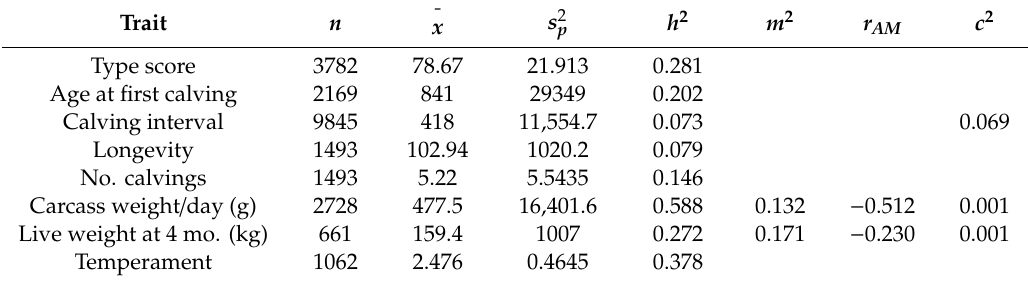
¯ x = mean; s 2 p = phenotypic variance) and Table 3. Descriptive statistics ( n = number of records; estimated genetic parameters ( h 2 = heritability of direct e ff ects; m 2 = heritability of maternal e ff ects; r AM = correlation between direct and maternal genetic e ff ects; c 2 = proportion of variance due to permanent environmental e ff ects) for the traits analyzed.